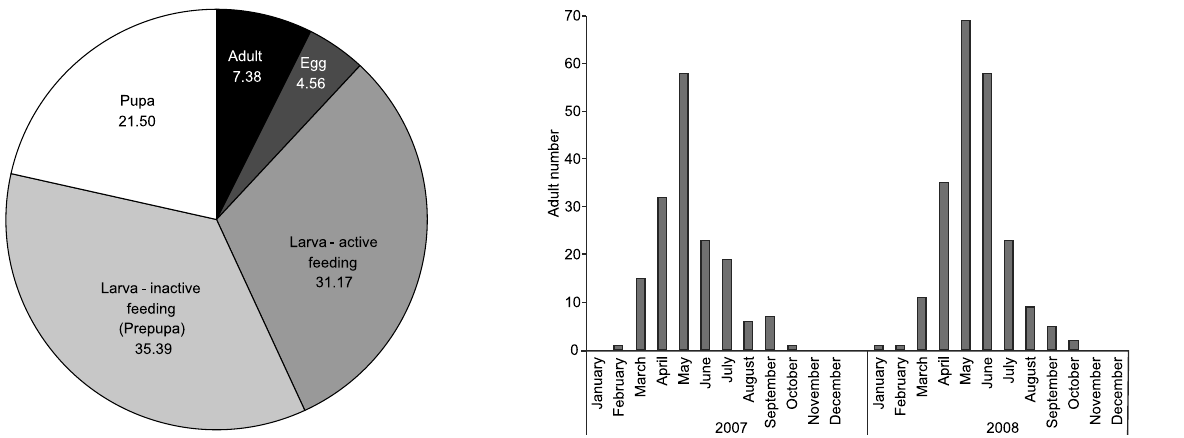
Figure 1. Duration (%) of each developmental period for Agrotis male- fida reared at 25 ± 1°C, 70 ± 10% RH and 14 hours photo phase.